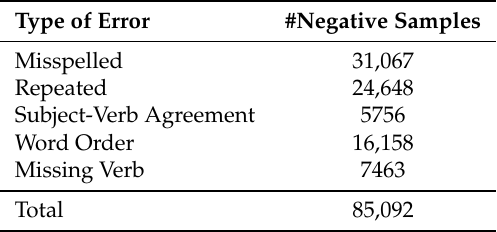
Table 3. Distribution of General